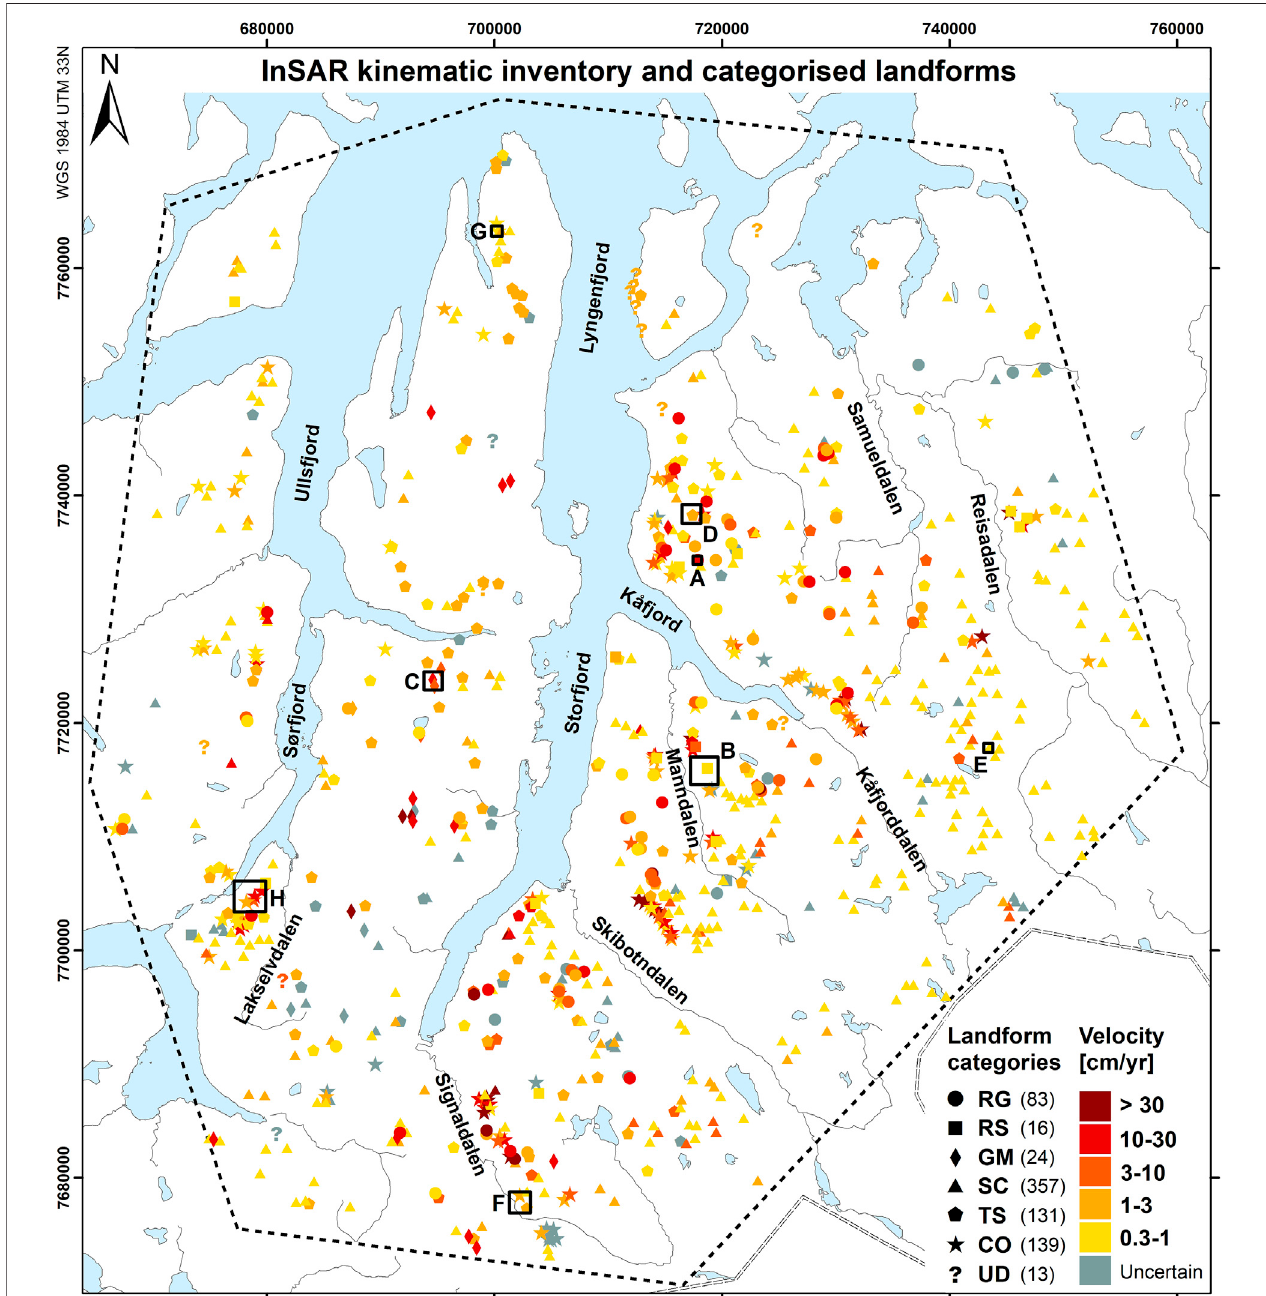
FIGURE 5 | InSAR kinematic inventory: slope movement categorised by landform type. Acronyms refer to rock glacier (RG), rockslide (RS), glacier/moraine (GM), talus/scree deposit (TS), soli fl uction/cryoturbation (SC), composite (CO) and unde fi ned (UD). Numbers in parentheses in the legend are the total numbers of identi fi ed areas for each landform category. Grey symbols correspond to areas where slope movement has been detected and the landform type categorised, but the velocity is uncertain due to location on N-S slopes. Locations (A – F) are the areas detailed in Figures 3 , 6 . Sea, lakes, rivers and border from NMA (2020a).